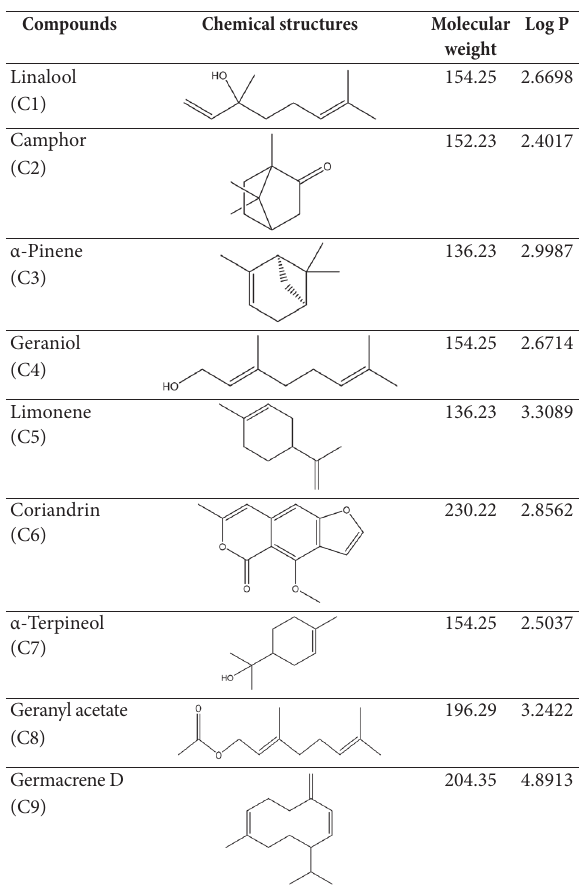
Table 1. The main compounds information from Coriander sativum L.